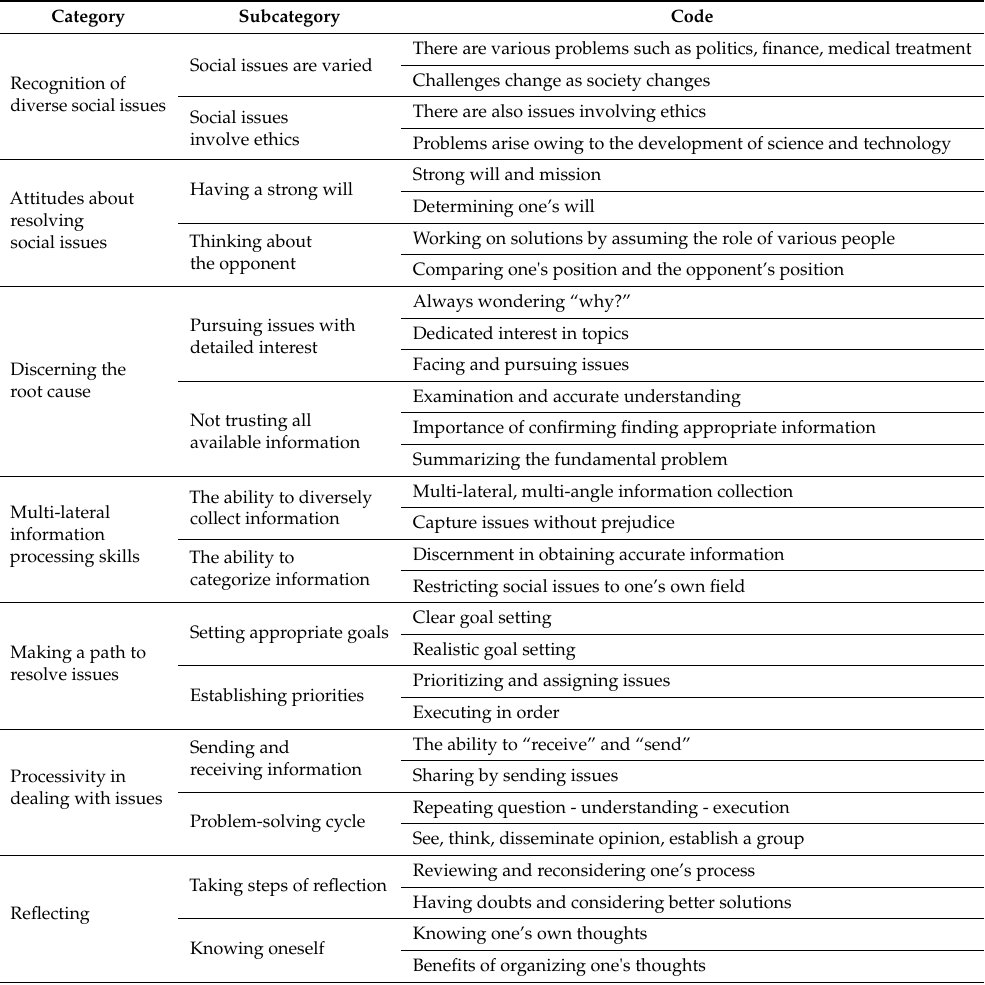
Table 1. Content categorization of Task 1 responses to “What kind of skills and attitudes do you think are necessary to resolve any kind of social